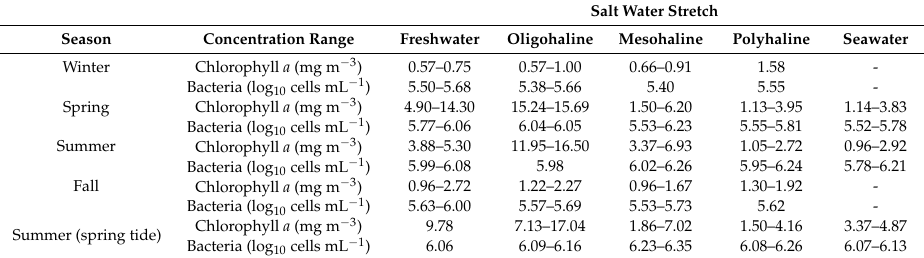
Table 1. Concentration ranges of chlorophyll a and bacteria in the Lima